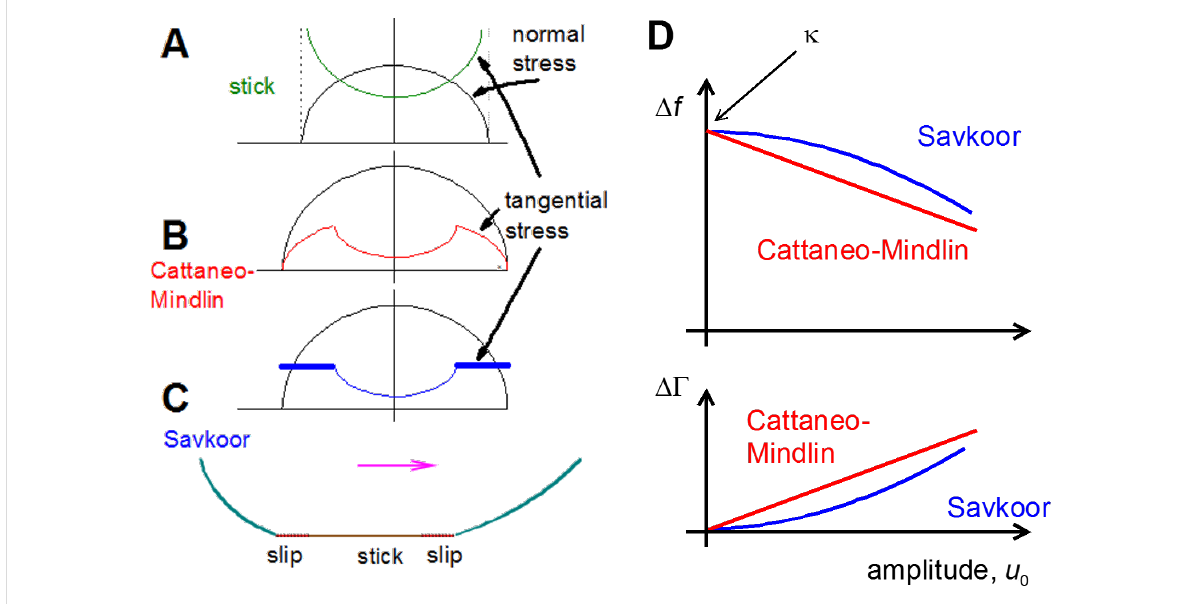
Figure 1: Sketch of the mechanisms underlying partial slip. A Hertzian contact under a tangential load has infinite tangential stress at the edge of the contact (A). This singularity is removed by allowing for slip in a circular region close to the edge. In CM theory, the tangential stress in the sliding region is proportional to the normal stress, where the latter follows the Hertz model (B). In an alternative model formulated by Savkoor, the tangential stress in the sliding region is constant (C). When probing such contacts with the contact resonance method, the two models lead to different depen- dences of the shifts in frequency, Δ f , and shifts in bandwidth, ΔΓ , on the amplitude, u 0 . Δ f and ΔΓ depend linearly and quadratically on amplitude for the CM model and the Savkoor model, respectively